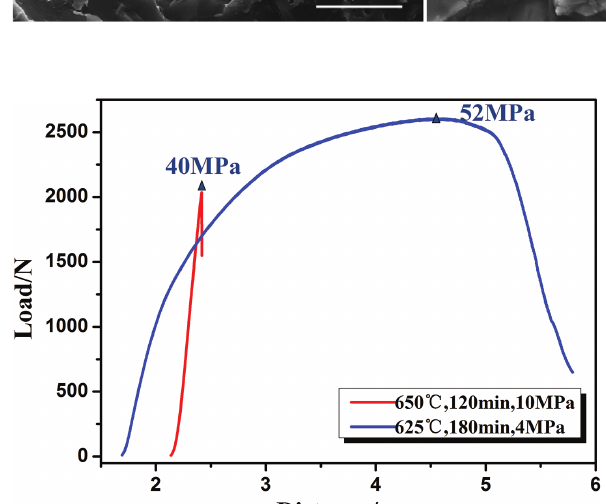
Figure 9: Tensile fractographs of the bonded joints.